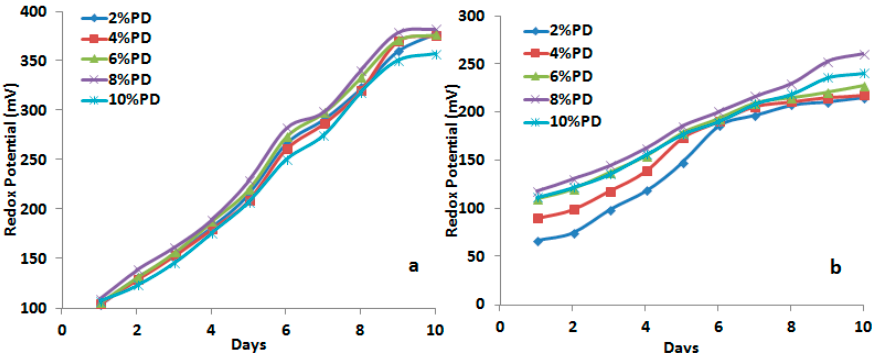
Figure 6. Variation of redox potential during bio-leaching of PCB at the different solid-liquid ratios, 308 K and pH 2.0 [( a ) bacterial leaching; ( b ) fungal leaching].